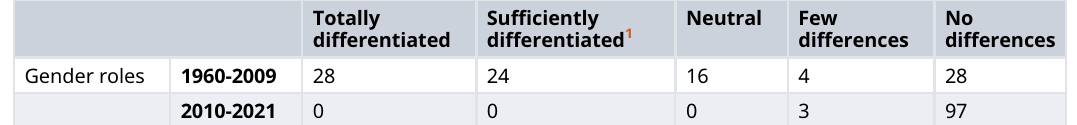
Table 5. Representation of gender